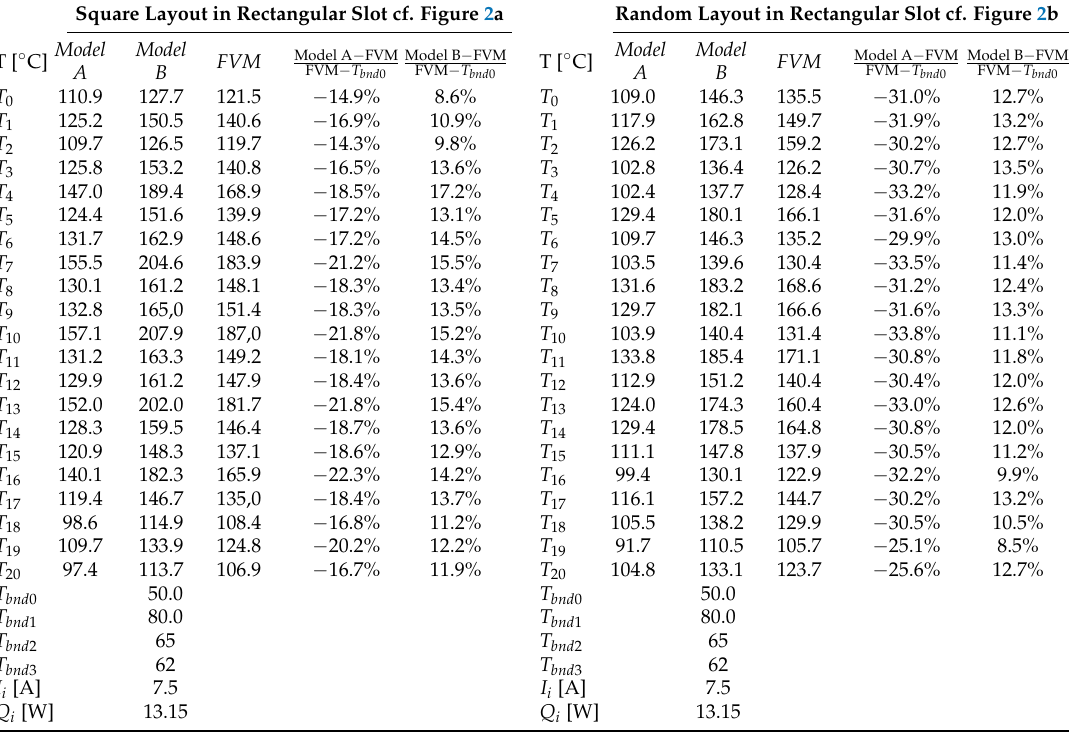
Table 1. Results for square and random layout in rectangular slot with the model A, B and Finite Volume Method (FVM) compared. Corresponding thermal contour in Appendix B respectively in Figure A1 and Figure A2. Square Layout in Rectangular Slot cf. Figure 2a Random Layout in Rectangular Slot cf. Figure